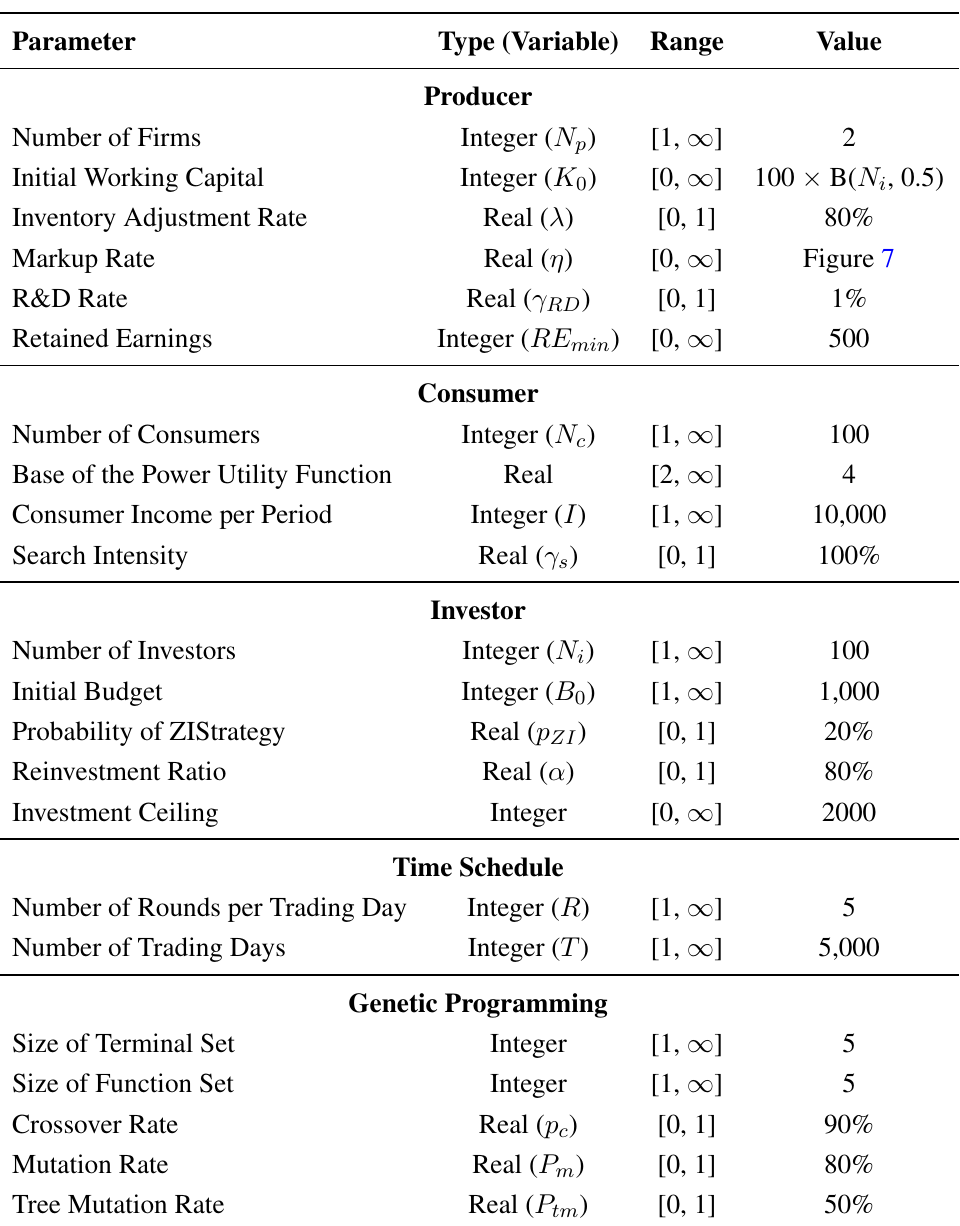
Table 1. The parameter